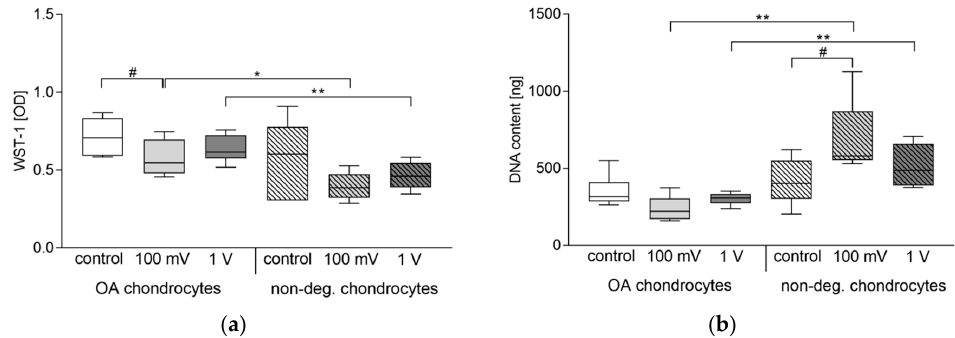
Figure 4 . Cellular activity of human chondrocytes following electrical stimulation with 1 kHz and either 100 mV or 1 V. Chondrocytes derived from non-degenerative ( n = 4) or osteoarthritic (OA) cartilage ( n = 6) were seeded on collagen scaffolds and stimulated over a period of seven days. Afterwards, metabolic activity was determined via water-soluble tetrazolium salt (WST-1) assay ( a ) and DNA content was analyzed by peqGOLD Tissue DNA Mini Kit ( b ). Data are presented as boxplots. Statistical analysis within a stimulation group was performed with Friedman test ( # p < 0.05). To compare two samples between OA and non-degenerative chondrocytes, Mann-Whitney-U-test was performed (* p < 0.05, ** p < 0.01).